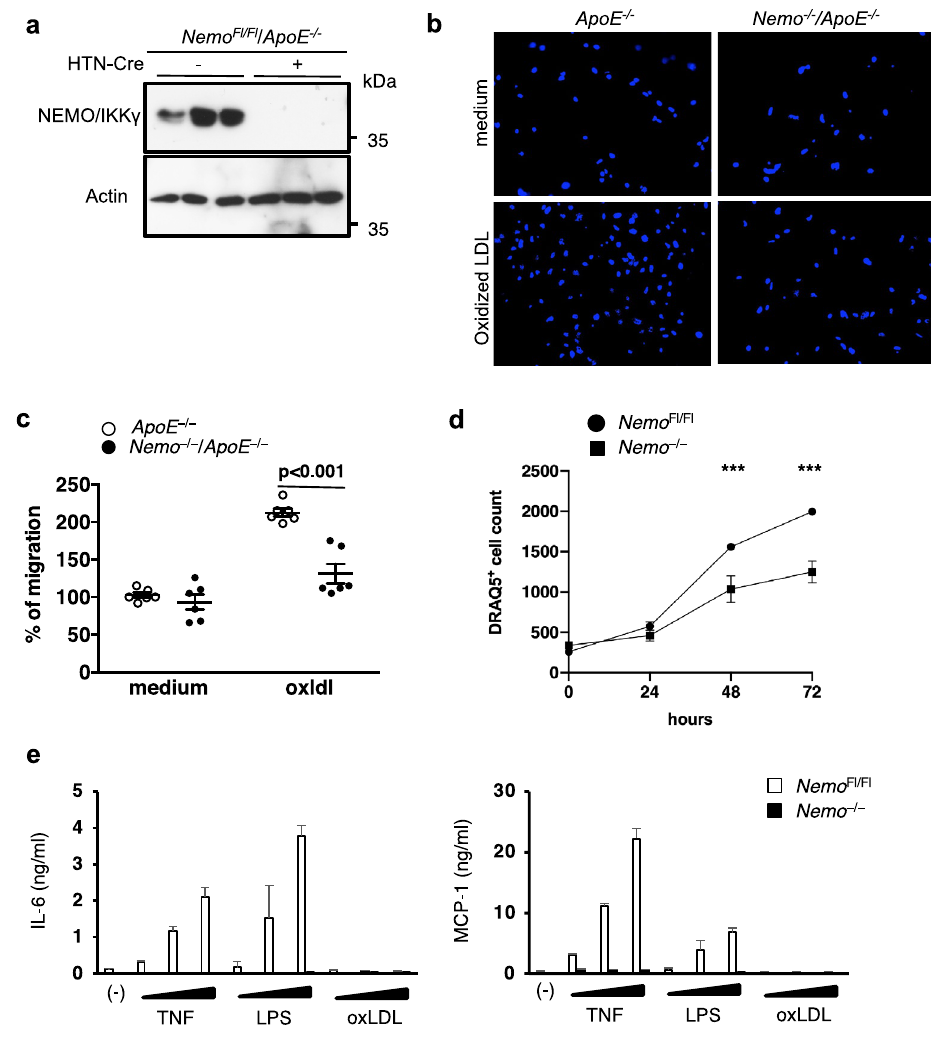
Figure 4. Deletion of NEMO in smooth muscle cells inhibits their activation upon oxidized LDL stimulation and inflammatory stimulus. ( a ) Presentation of the deletion efficiency in vitro using HTN-Cre mediated excision of the NEMO allele. Three independent isolations of smooth muscle cells are depicted. Uncropped blots are presented in Supplementary Fig. 4. ( b ) Representative pictures of migrating smooth muscle cells (Transwell assay) after staining with DAPI. ( c ) Graph showing quantification of the migration of ApoE − / − or Nemo − / − /ApoE − / − smooth muscle cells towards oxidized LDL. The graph represents the combined results of two independent experiments performed with ApoE − / − or Nemo − / − /ApoE − / − smooth muscle cells from 3 independent isolations (2-way ANOVA with Bonferroni post-hoc test) ( d ) Graph showing quantification of the proliferation of Nemo Fl/Fl or Nemo − / − smooth muscle cells. Data are presented as mean ± SEM and are representative of three independent experiment with similar results. ( t test, ***p < 0.05). ( e ) Nemo Fl/Fl or Nemo − / − smooth muscle cells were stimulated with TNF (0.1, 1, 10 ng/ml), LPS (0.1, 1, 10 ng/ml), and oxidized LDL (10, 30 100 µg/ ml) or left unstimulated. At 24 h after stimulation, the supernatants were collected, and the concentration of IL-6 and MCP-1 were determined by ELISA. Data are presented as mean ± SD and are representative of three independent experiments with similar